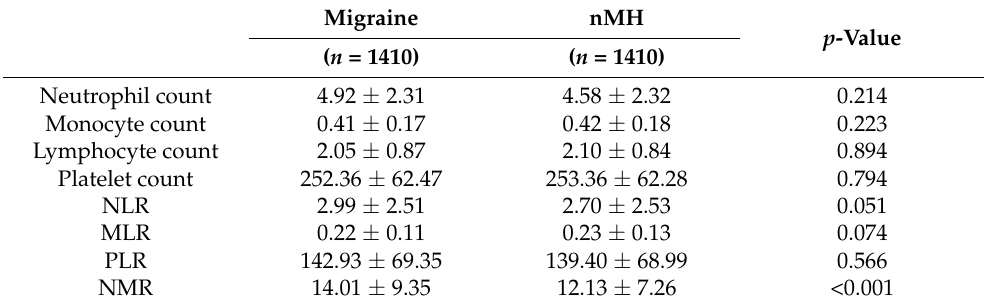
Table 6. Peripheral inflammatory markers of the migraine and non-migraine headache groups after PSM.